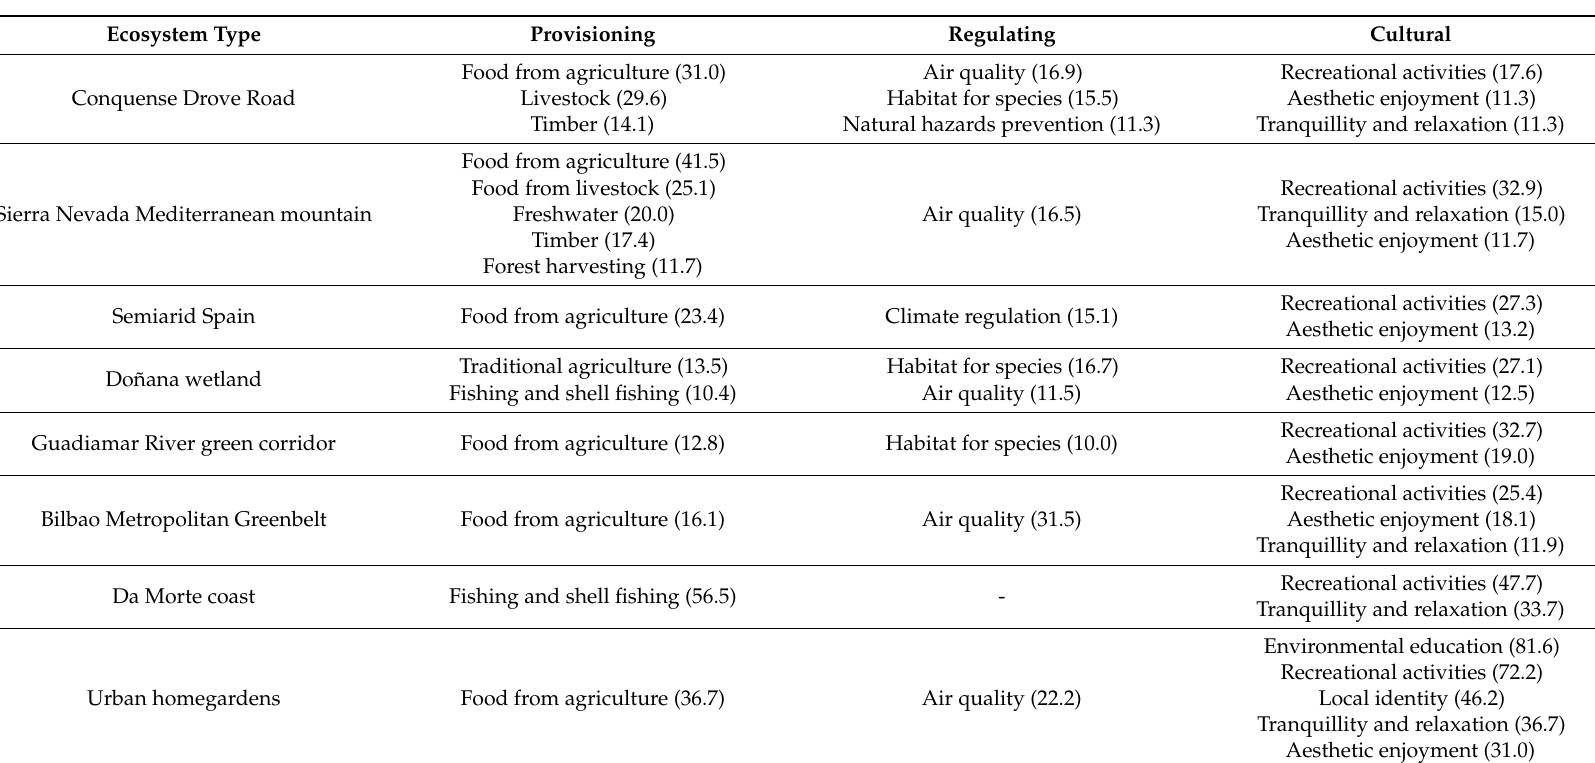
Table 2. Main ecosystem services (ES) elicited in each study site (we have included those mentioned as important by at least 10% of the respondents in a particular ecosystem type; figures (in %) are presented in